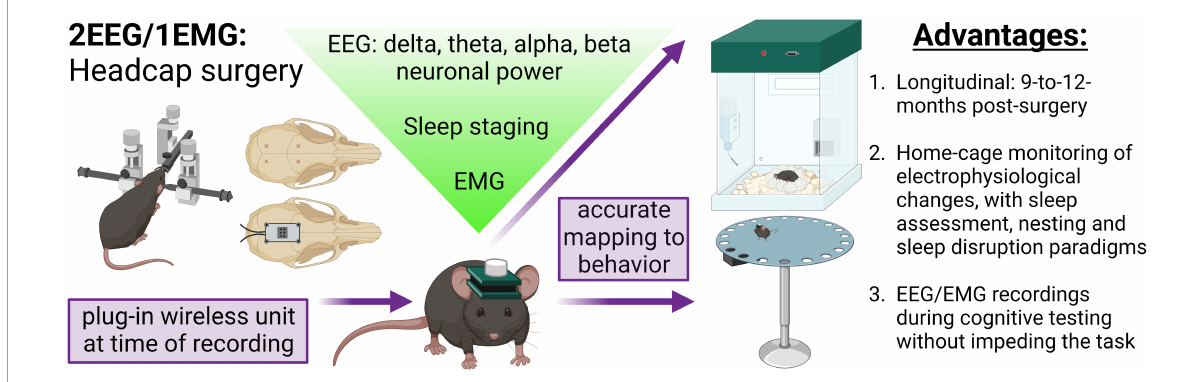
FIGURE1 Concurrent EEG/EMG recordings with behavioral testing in mice. Schematic of the method employed. Mice underwent stereotaxic surgery to implant a headcap with two EEG channels and EMG wires in the nuchal muscle. EEG signal was derived from four stainless steel screw electrodes implanted at Bregma –2–2.5 mm AP, 1.5 ML, and Bregma 3.5–4 mm AP, 1.5 ML, as approximately indicated by the red × markings. A lightweight and small headcap was connected to the screws on the skull top and secured with dental cement. At the time of recording, a wireless potentiostat was plugged-in to acquire oscillatory signals. The EEG and EMG data can be utilized to assess alterations in neuronal frequency and sleep staging. Critically, the EEG/EMG system exhibits 9-to-12-month longevity and does not impede mice movement, allowing simultaneous electrophysiological and behavioral testing. In the present study, we demonstrate a combination of EEG/EMG recordings with home-cage locomotion, sleep assessments at baseline and after disruption, nesting, and, notably, during cognitive testing in the Barnes maze. We propose this system is feasible for concurrent recordings in a multitude of behavioral tasks beyond those investigated in the current study. Created with